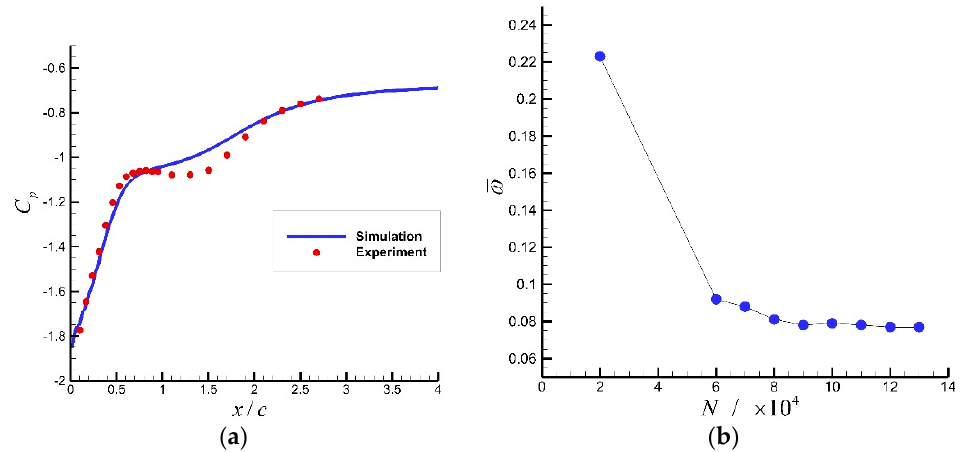
Figure 2. Validation and grid-independent study of the numerical method: ( a ) simulated and experimental static pressure coefficient C p on the suction surface of the curved diffuser without any flow control; ( b ) total pressure loss coefficient ω versus grid number N .